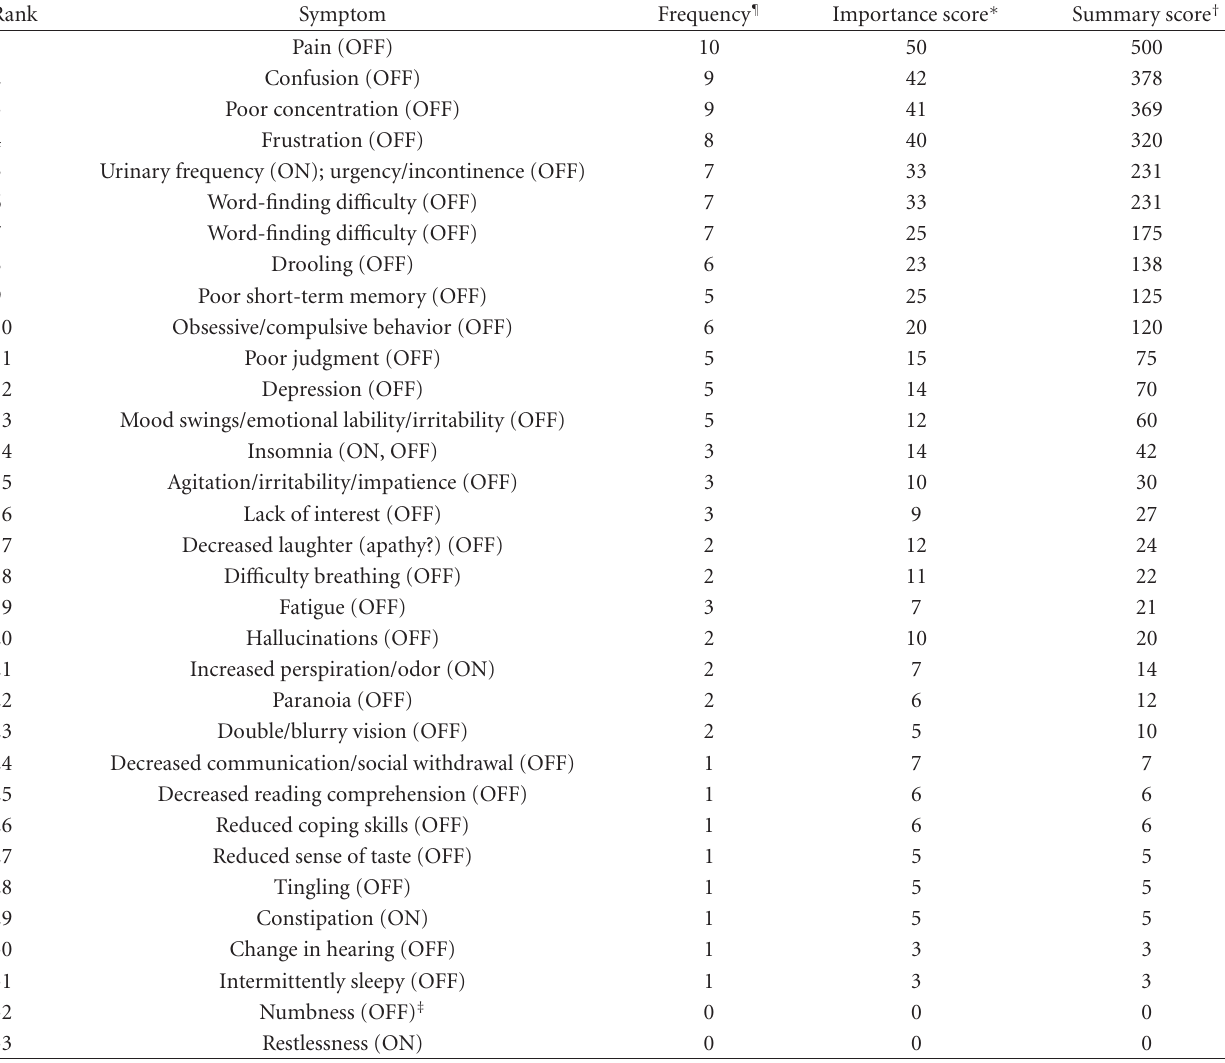
Table 2: Ranking of non-motor fluctuations (NMFs) symptoms by study participants ∗